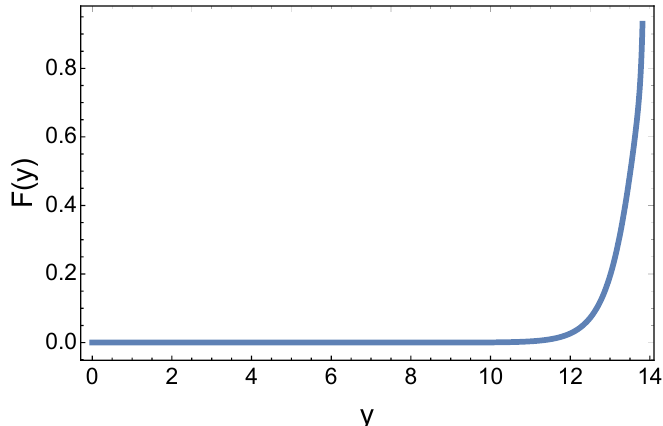
Figure 12. The bulk pro(cid:12)le of the (unnormalized) (cid:13)uctuation of the metric F ( y ) in (3.1). y 1 = 13 : 8, v 1 = 5, T 1 = (cid:0) 60, (cid:15) = 10 (cid:0) 13 .